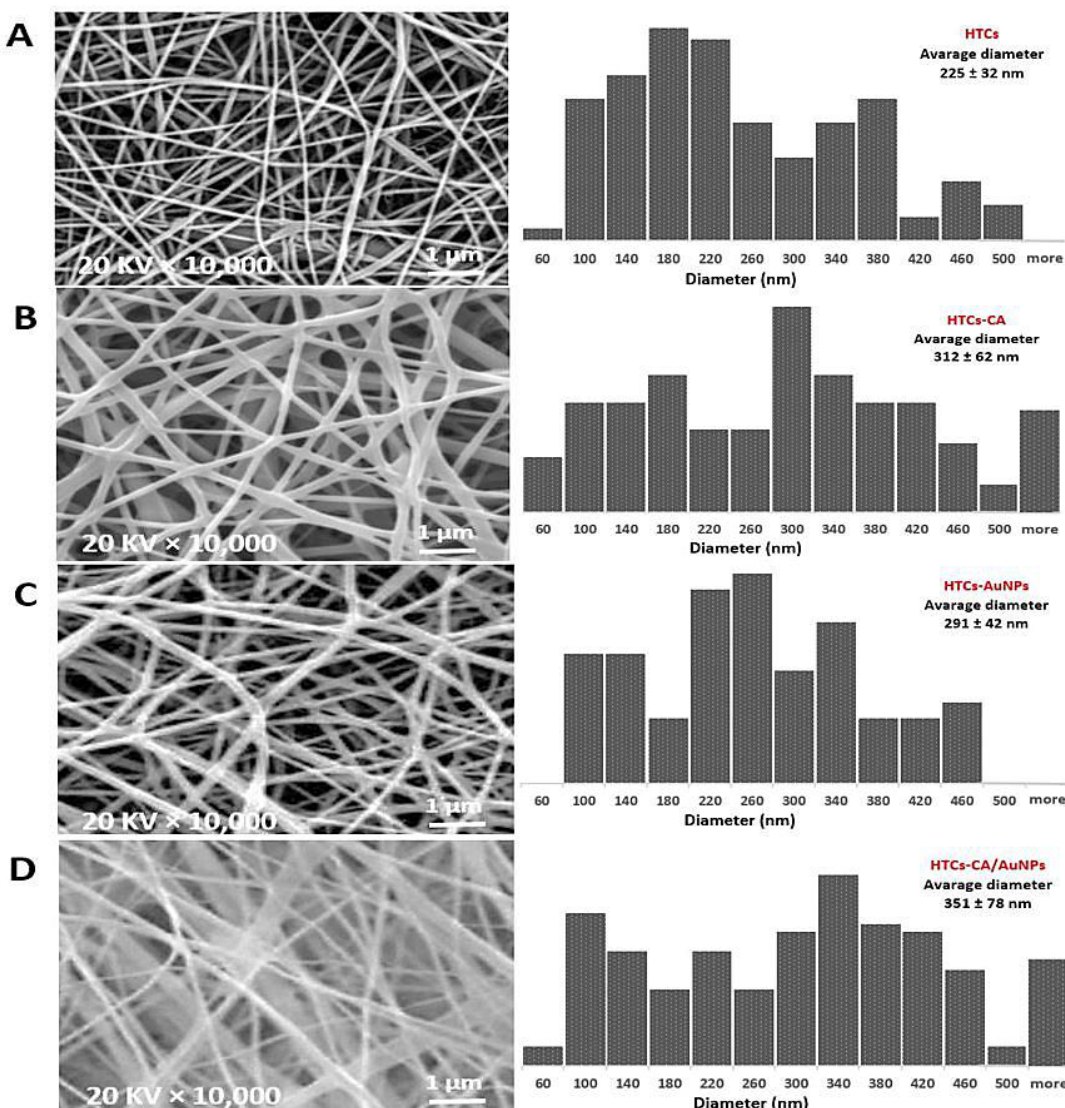
Figure 1. SEM images of the nanofibers mats and different diameter distribution represent changes in morphology and nanofiber diameter of the HTCs mat due to its enriching with the capsaicin, AuNPs and their combination (capsaicin/AuNPs). ( A ) HTCs, ( B ) HTCs-capsaicin, ( C ) HTCs-AuNPs and ( D ) HTCs-capsaicin/AuNPs. (CA refers to capsaicin).